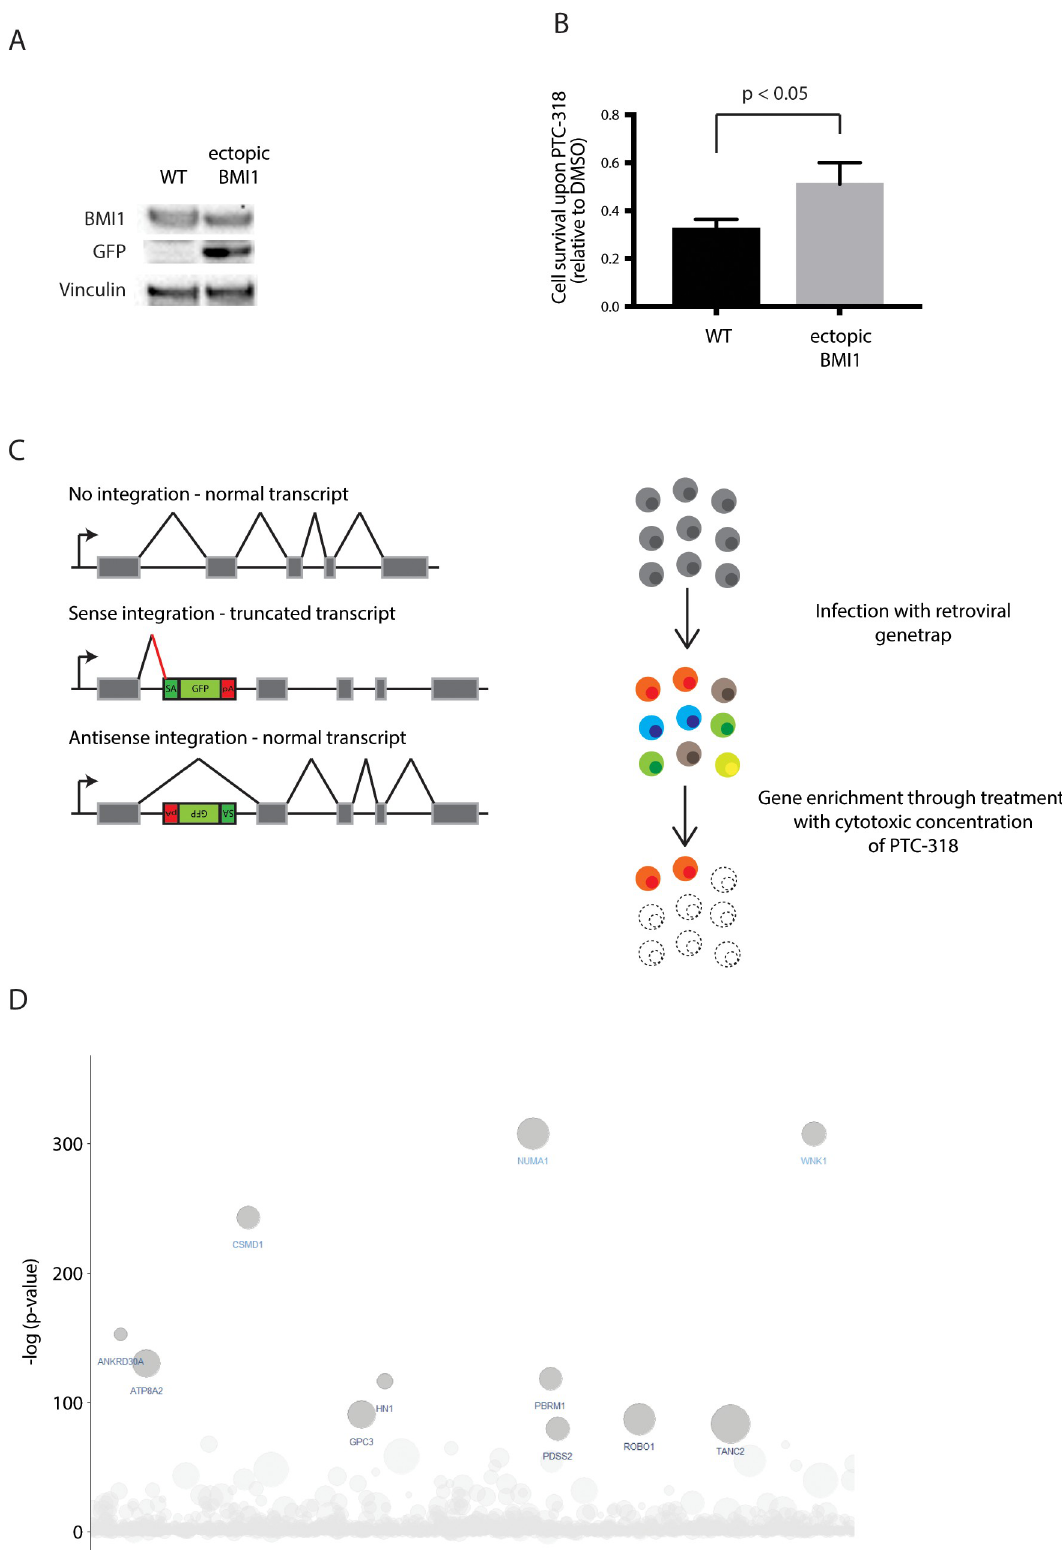
Fig 2. A haploid genetic screen shows enrichment of NUMA1 mutations upon BMI1 inhibition with PTC-318. (A) BMI1 and GFP protein expression of wildtype HAP1 cells and HAP1 cells ectopically expressing BMI1 in the absence of 3’UTR through